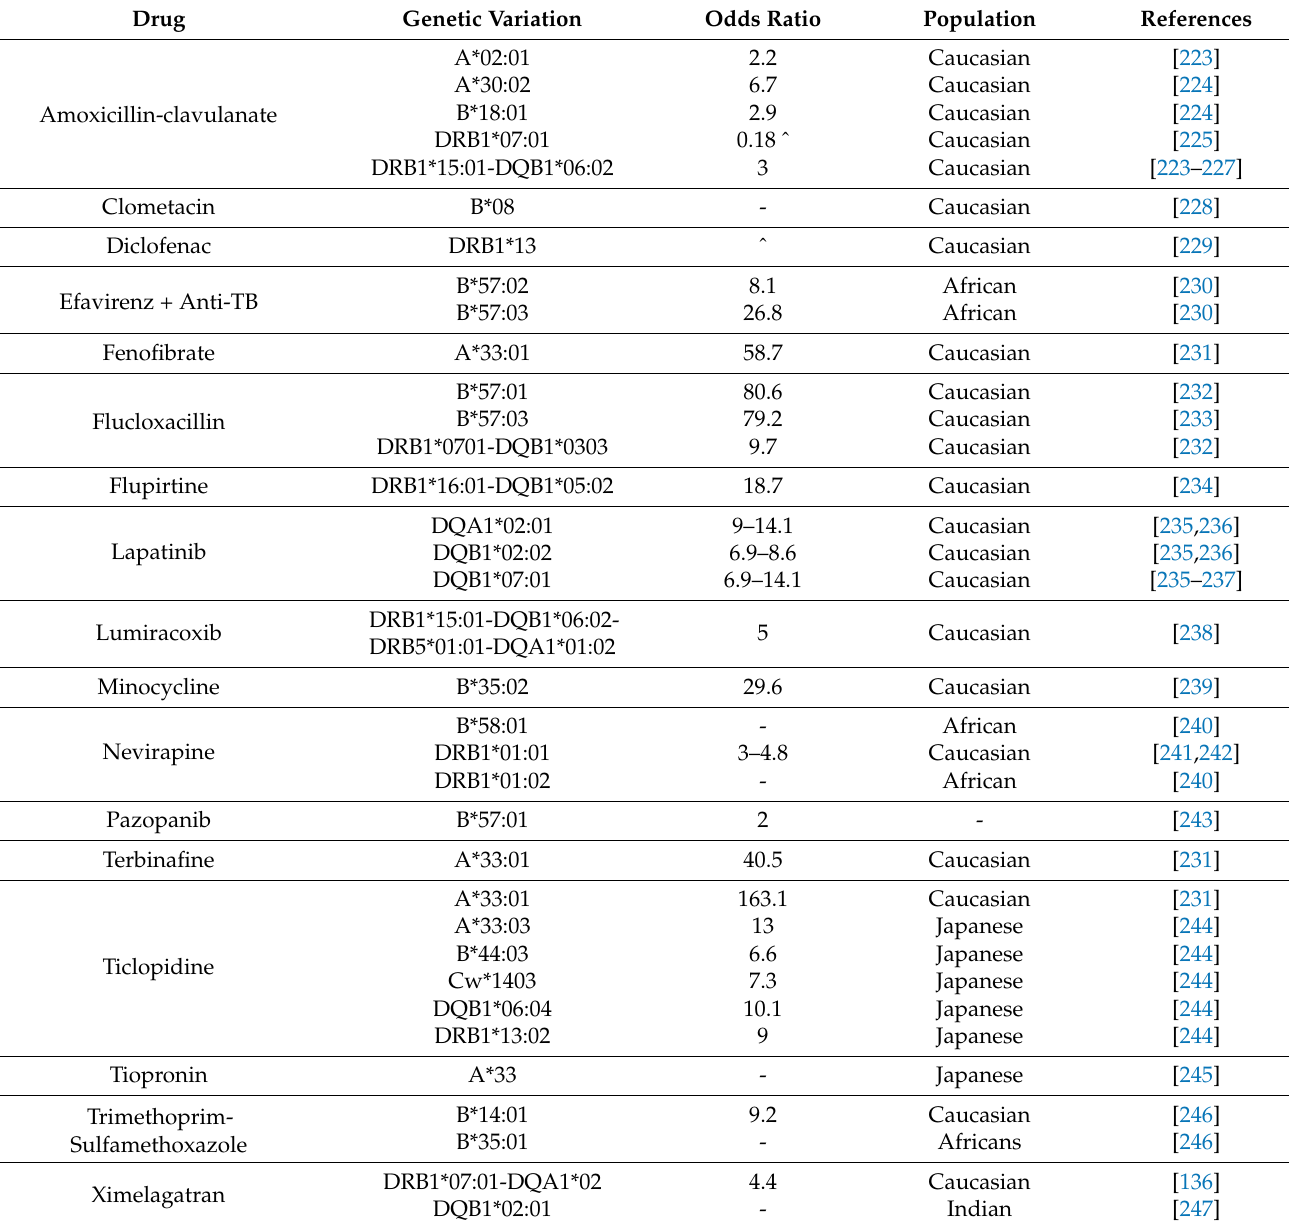
Table 3. Human leukocyte antigen (HLA) risk alleles associated with DILI susceptibility. Drug Genetic Variation Odds